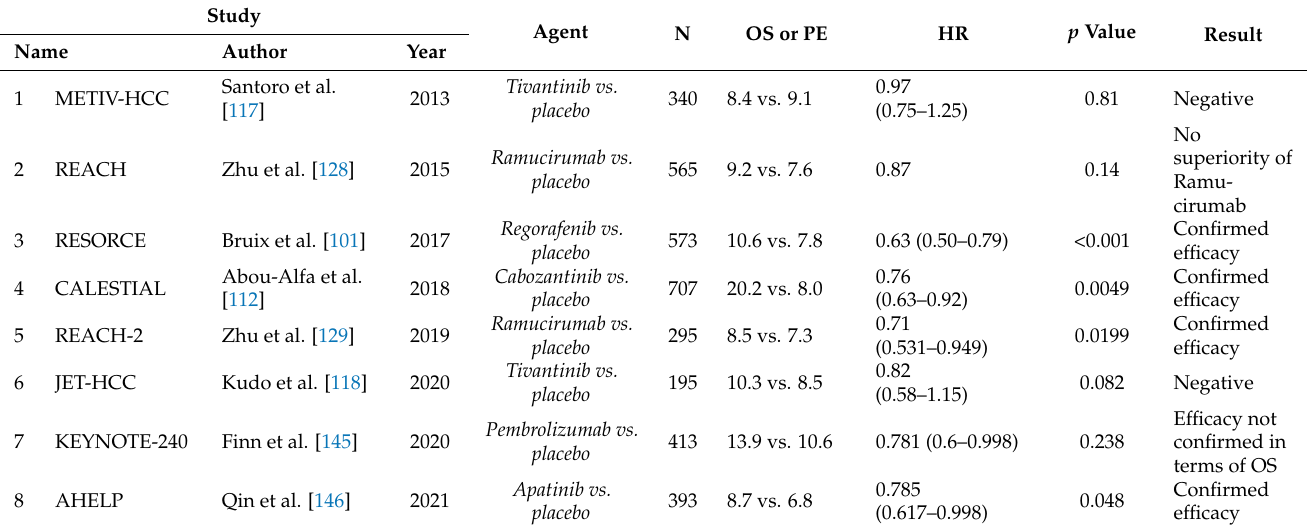
Table 2. Phase III trials that evaluated targeted agents as second-line